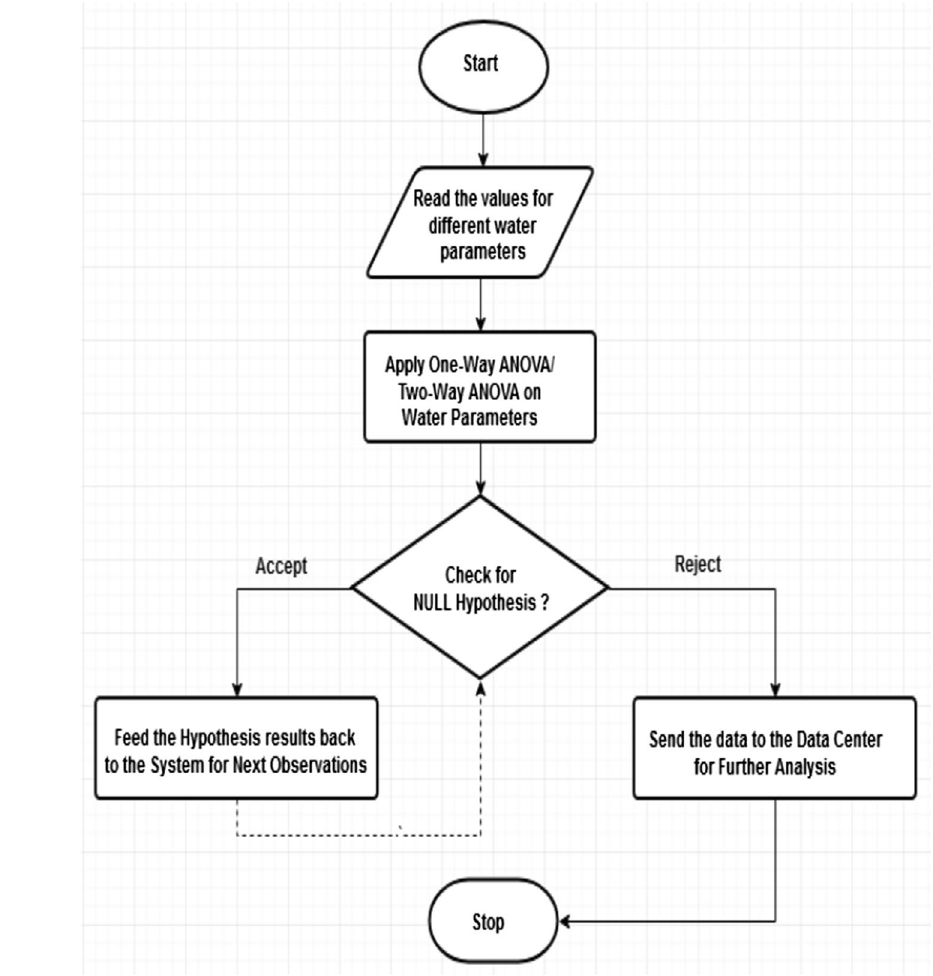
Fig. 3 The hypothesis check for